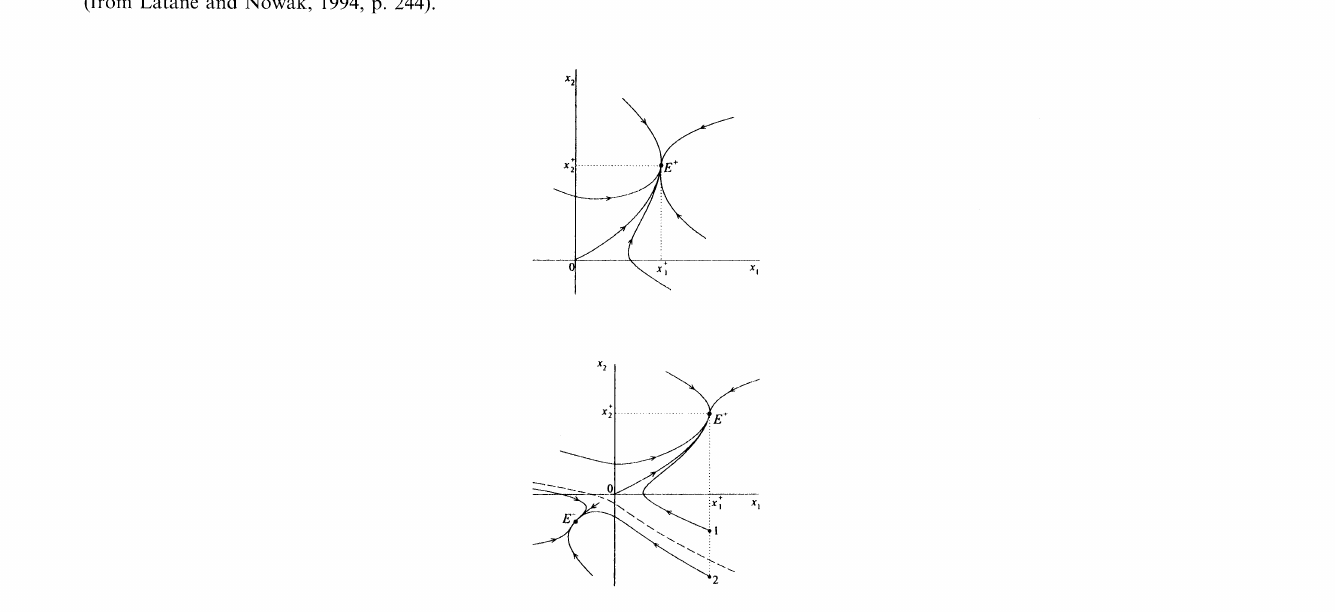
FIGURE 5 Spatial distribution of attitudes before (A) and after (B) social influence. Faces reflect one of two attitudinal positions (from Latan6 and Nowak, 1994, p. 244).